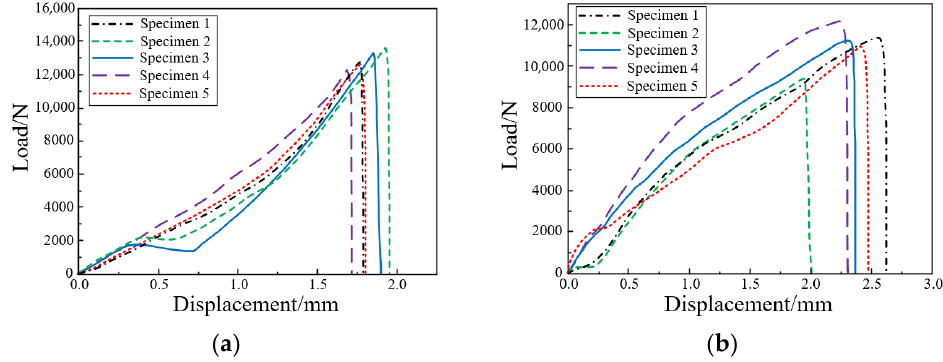
Figure 12. Load-displacement curve: ( a ) Butt tensile specimen; ( b ) Lap shear specimen. Table 4. Mechanical properties of Araldite 2015 structural adhesives.